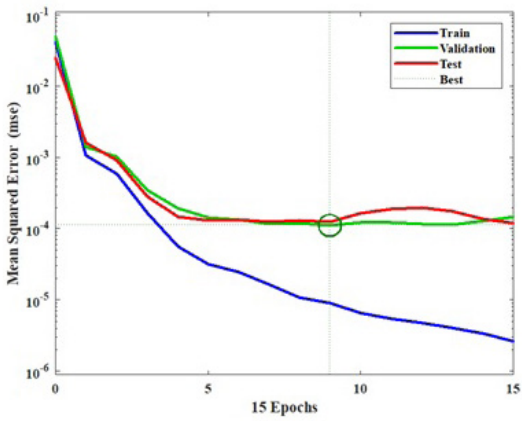
Figure 14. MSE against epoch numbers during the training process of the ANN